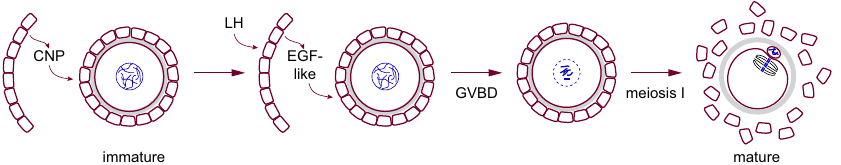
Fig. 1 Schematic of maturation. The oocyte is surrounded by cumulus granulosa cells (one layer only shown for simplicity). Prior to maturation, C-type natriuretic peptide (CNP) produced by the mural granulosa cells of antral follicles maintains the immature state. At ovulation, LH binds to receptors on mural granulosa cells, triggering release of EGF-like peptides. These bind to EGFR on both the mural and the cumulus granulosa. LH and EGFR activity cooperatively trigger maturation, marked by germinal vesicle breakdown (GVBD), completion of the fi rst meiotic division and alignment of the oocyte chromosomes on the metaphase II spindle. During maturation, the cumulus granulosa cells become displaced away from the